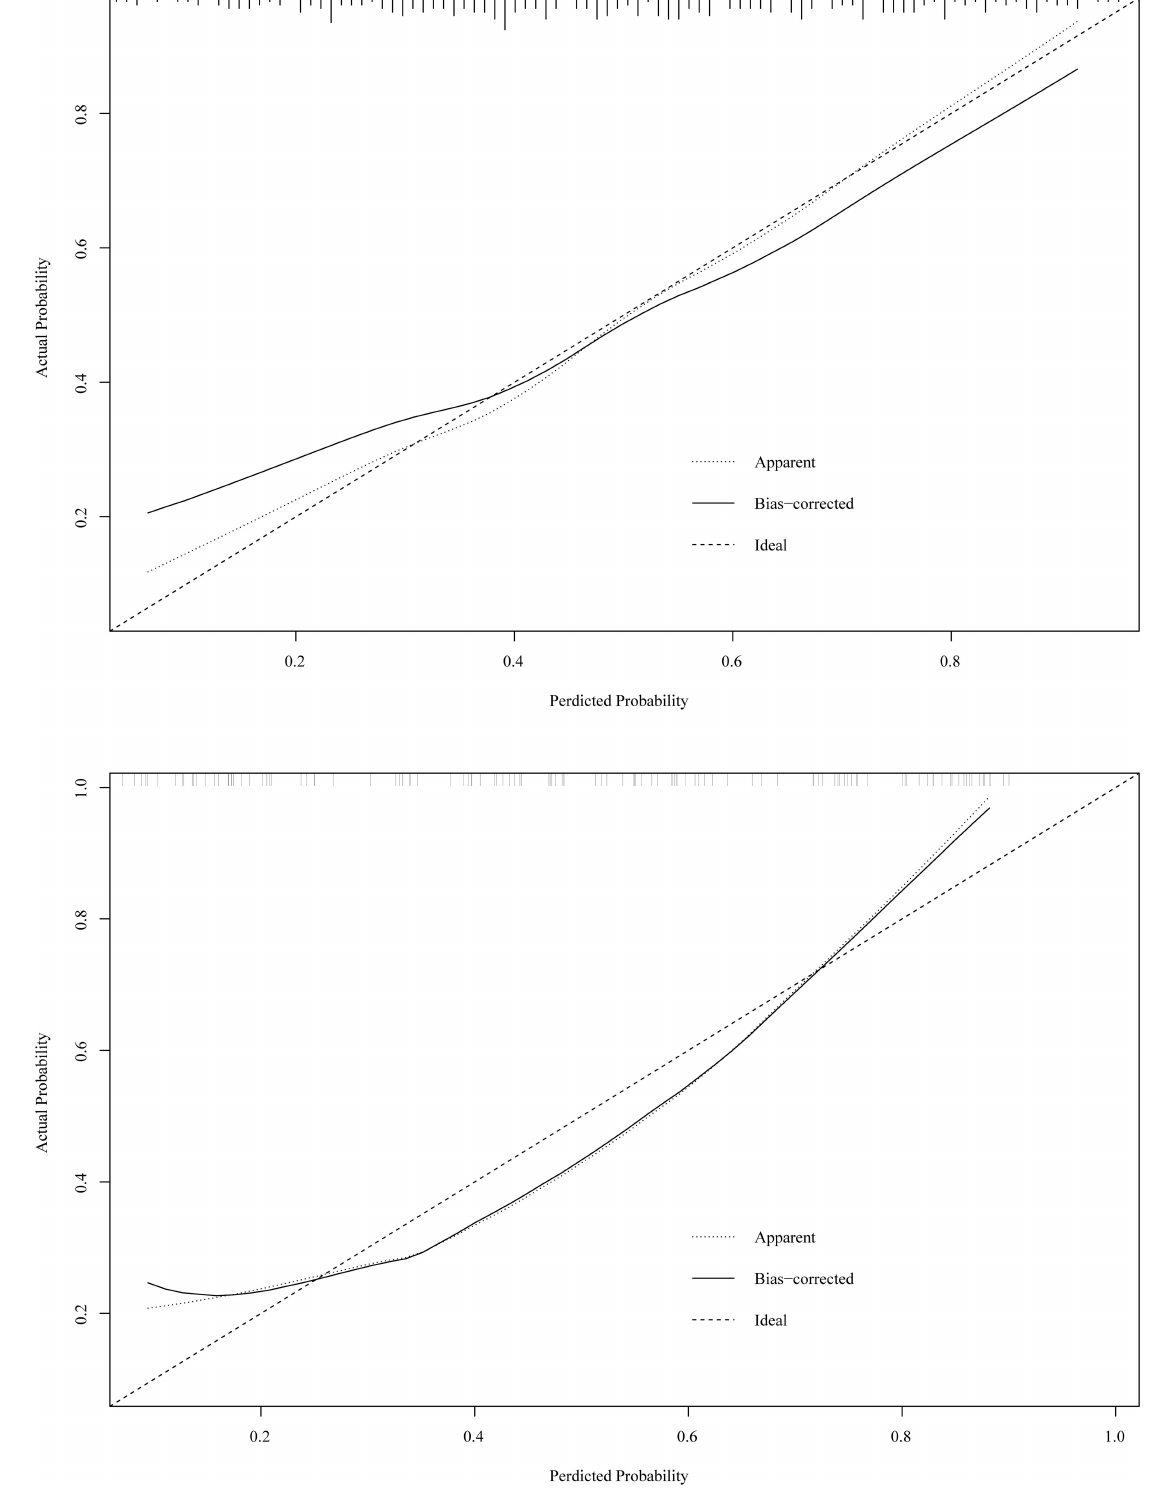
FIGURE5 The calibration curves of the training set and the testing set were respectively